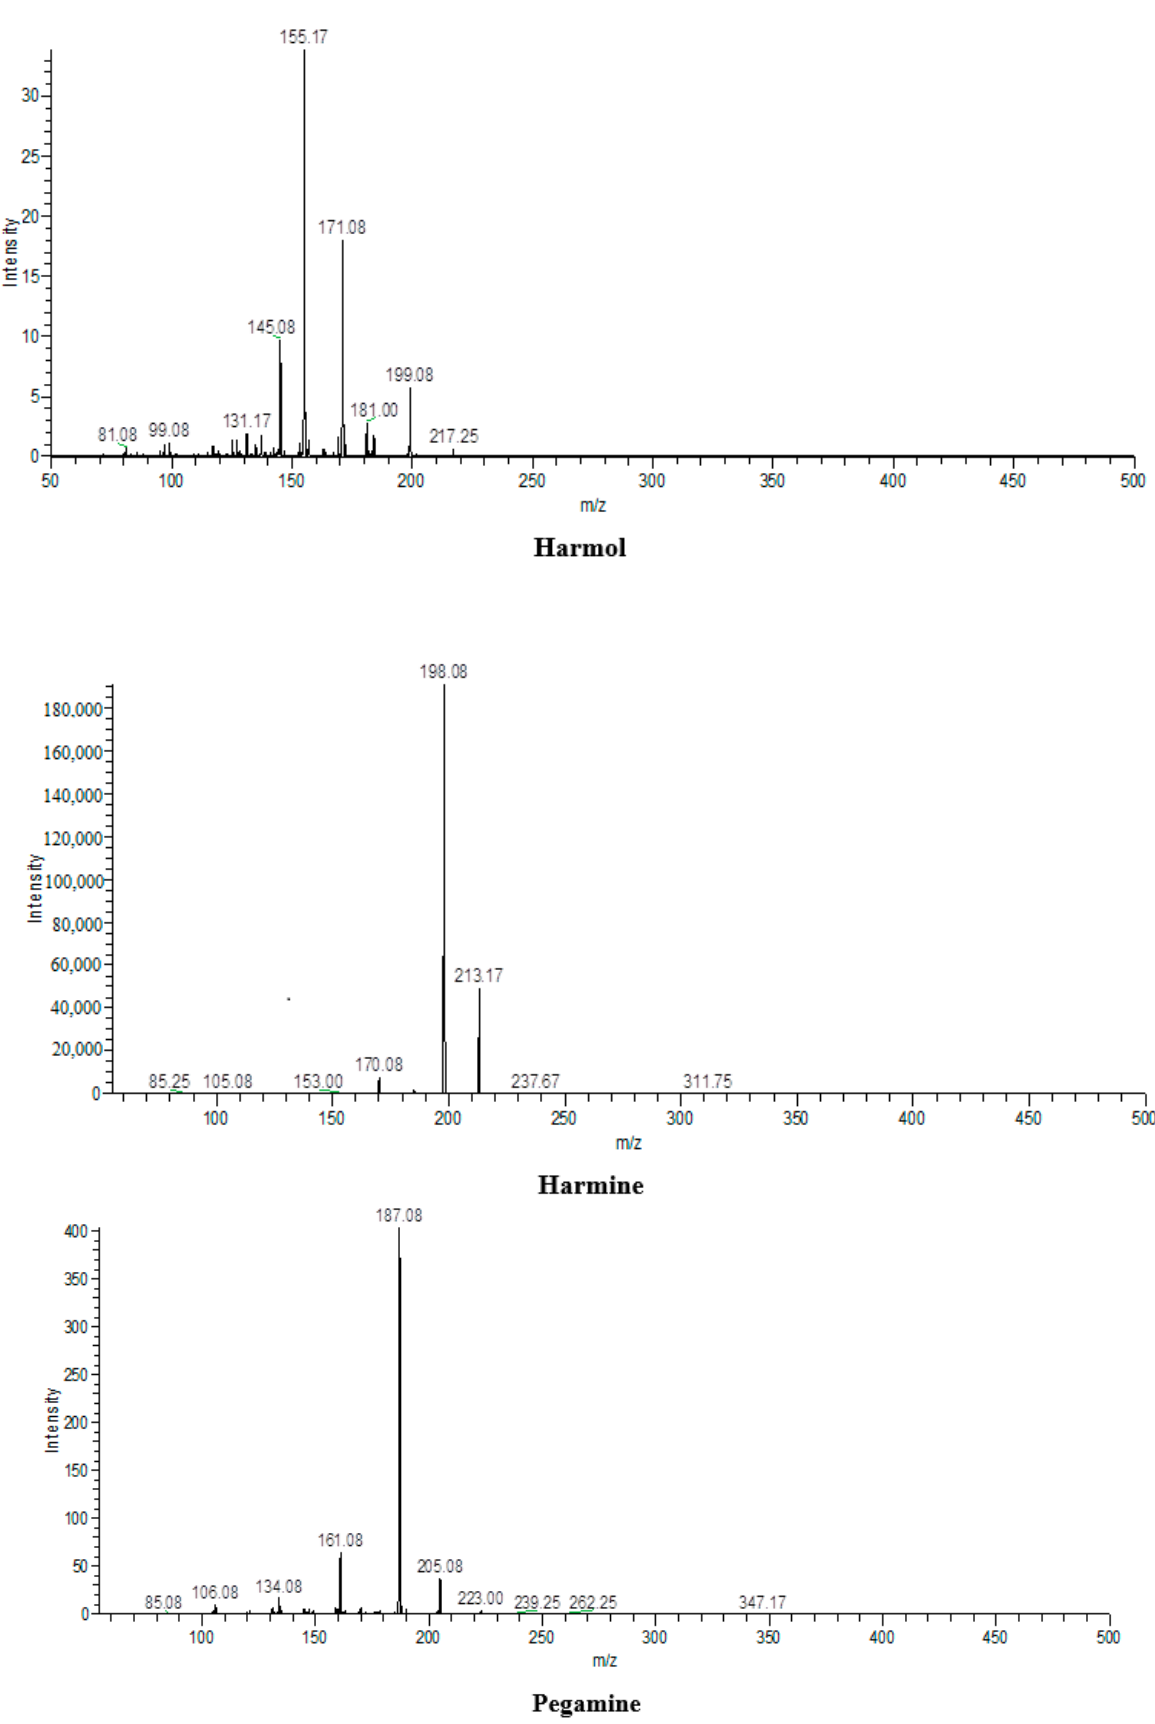
Figure 6. Mass spectra of different bioactive compounds found in PHMF2 of Peganum harmala .